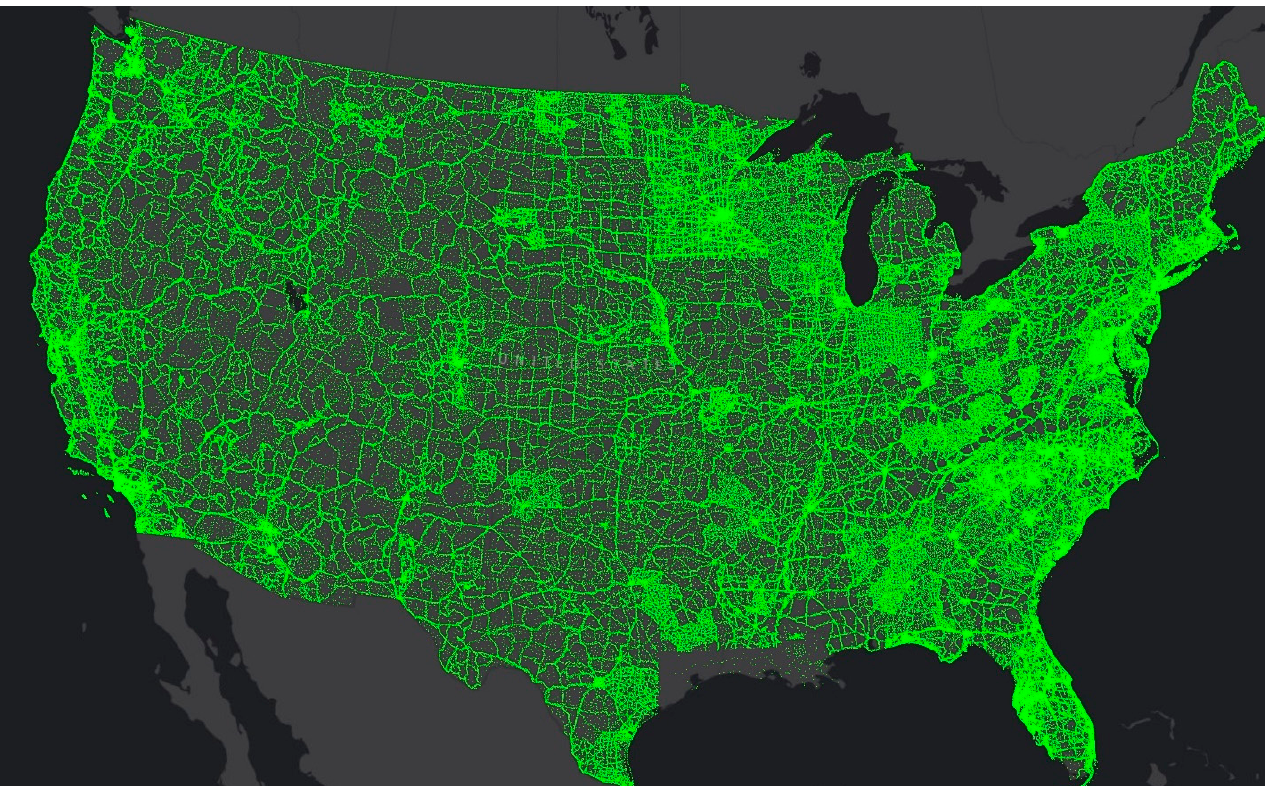
Figure 4. Locations of OPUS survey points ( n = 24,707).